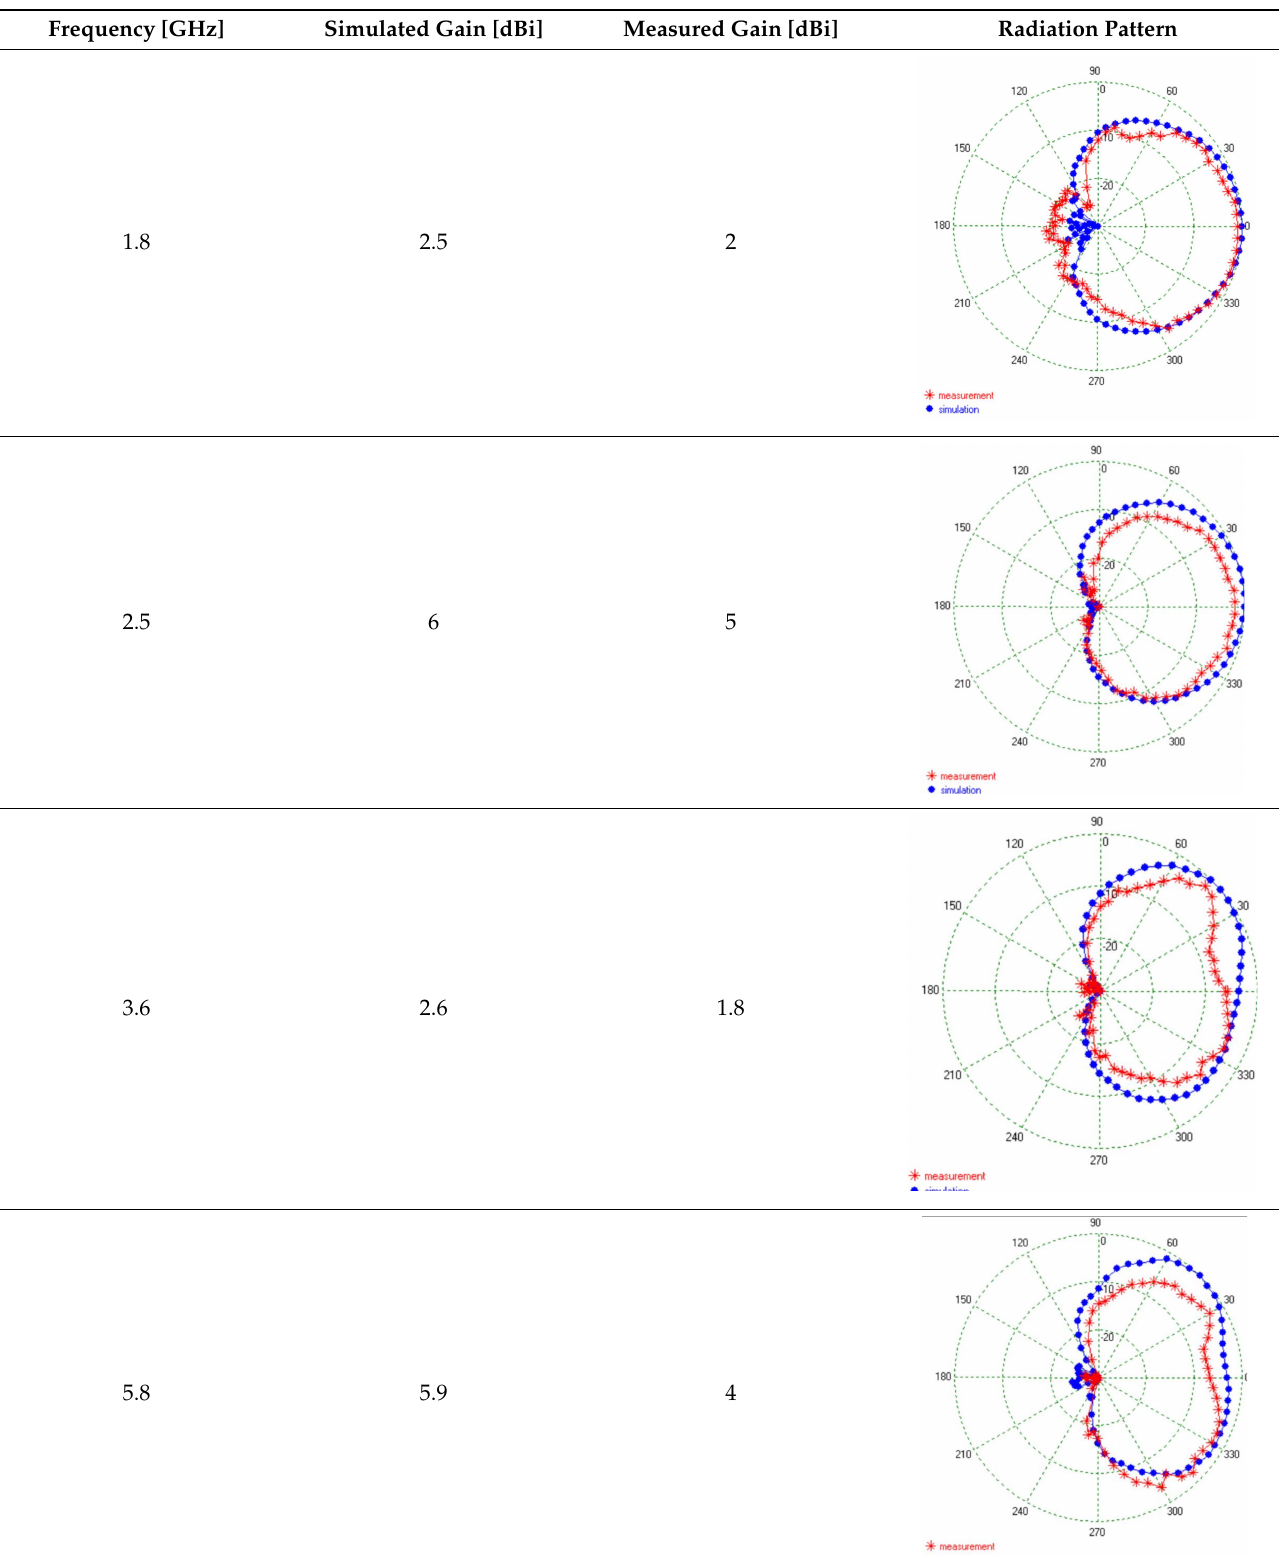
Table 9. Results of radiation pattern and antenna gain measurements in horizontal